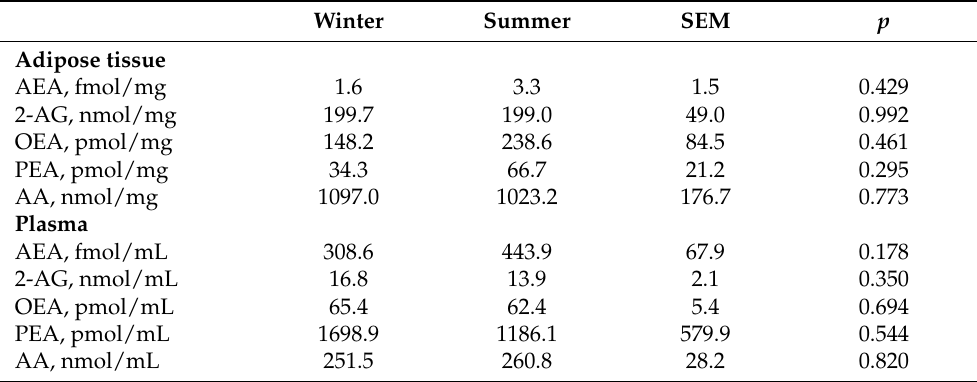
Table 3. Average concentrations of endocannabinoids (eCBs) in AT and plasma at 7 d PP from cows calving in winter ( n = 9) or summer ( n = 9).